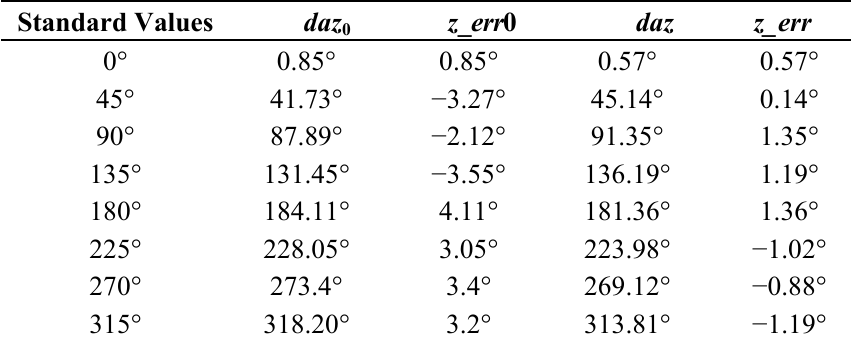
Table 2. The azimuth angle measurement